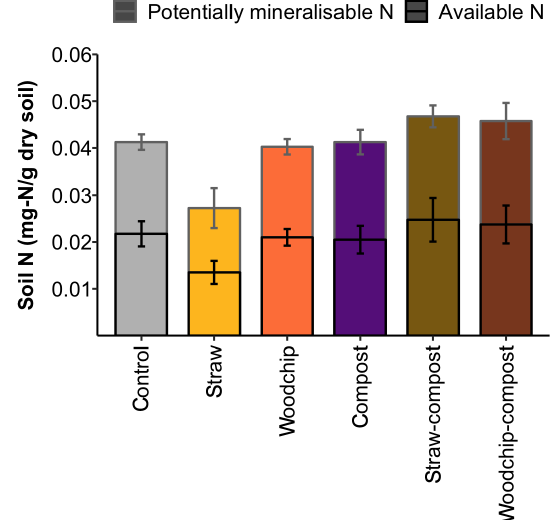
Figure 4. Available and potentially mineralisable N after each soil amendment treatment. Error bars represent the SEM of available and potentially mineralisable N separately ( n =